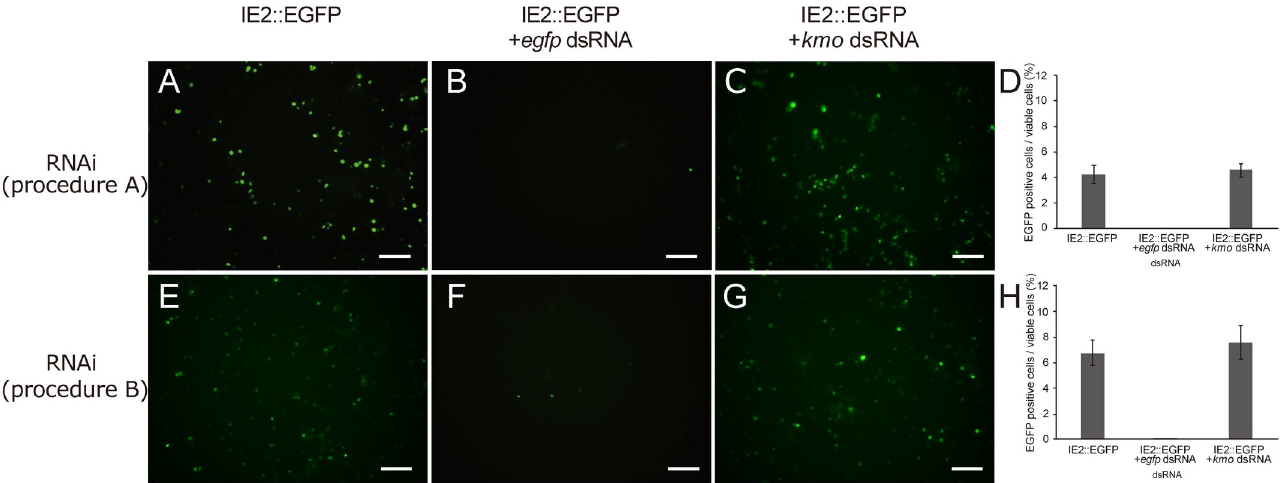
Fig 9. Fluorescent micrographs showing a decrease in EGFP emissions by RNAi-based gene silencing in ex vivo cultured cells. Top panels ( A - C ) show the effects of the application of dsRNA using the transfection reagent (RNAi, procedure A), and bottom panels ( E - G )show the effects of soaking with dsRNA without transfection reagent (RNAi, procedure B). Ex vivo cells were transfected with the IE2::EGFP vector ( A and E , IE2::EGFP), transfected with the IE2::EGFP vector and the application of egfp dsRNA ( B and F , + egfp dsRNA), and transfected with the IE2::EGFP vector and application of kmo dsRNA ( C and G , + kmo dsRNA). D , H . The transfection of and soaking with egfp dsRNA both decreased the proportion of EGFP-positive cells. Bars indicate the standard error of the mean of three replications.